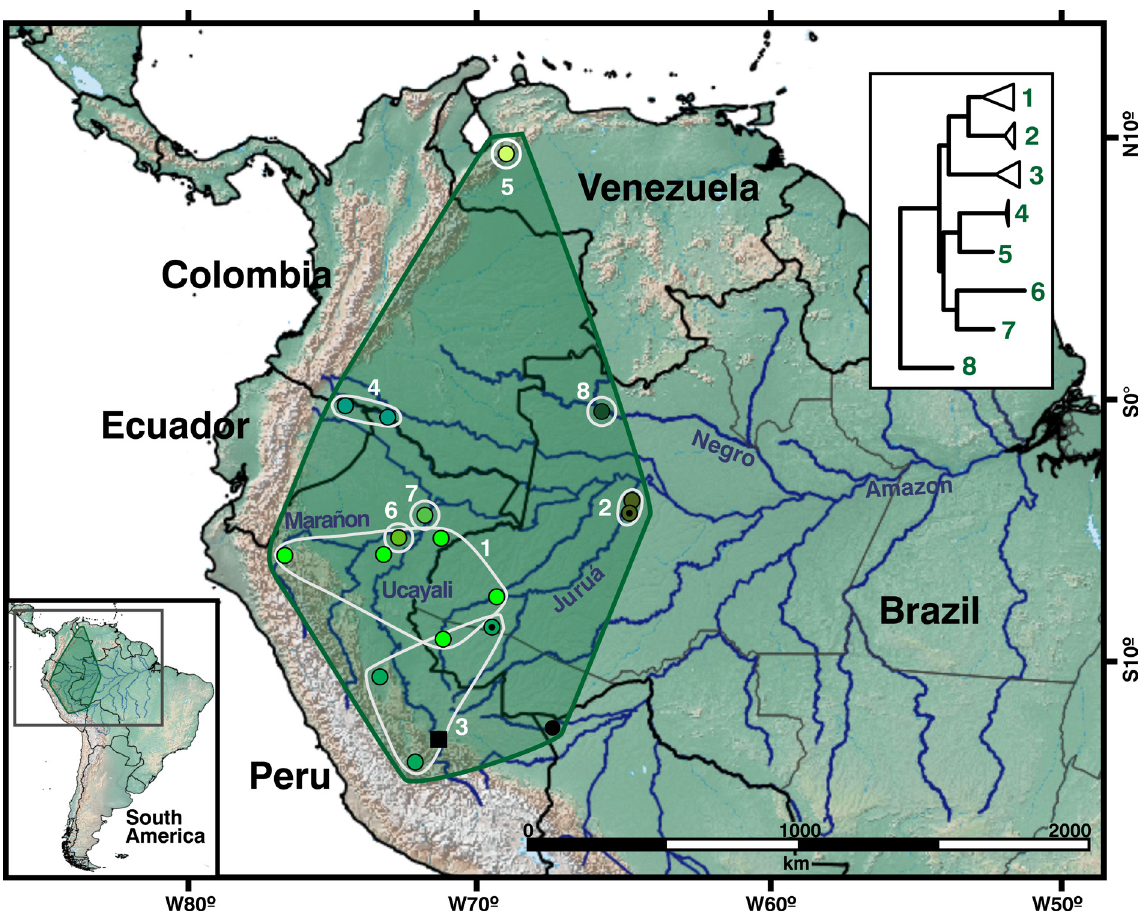
Fig. 2. Geographic distribution of the Adenomera simonstuarti species complex in northwestern South America; genetic lineage 3 corresponds to the nominal species. Phylogenetic relationships among the eight lineages are shown on the upper right. Black solid-filled symbols represent the localities reported in the original description (square = type locality at Camisea, Peru; circle = Pando, Bolivia). Black- dotted symbols indicate newly collected specimens from the Juruá River in the Brazilian